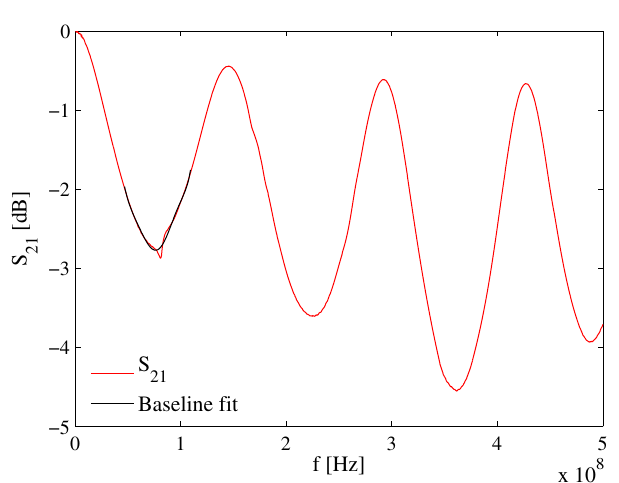
FIG. 13. Measured S 21 and baseline fit with the wire displaced by 5 mm and collimator jaws full gap of 10 mm. Note that the offset induced by the matching resistor and the attenuators has been removed from the S 21 .